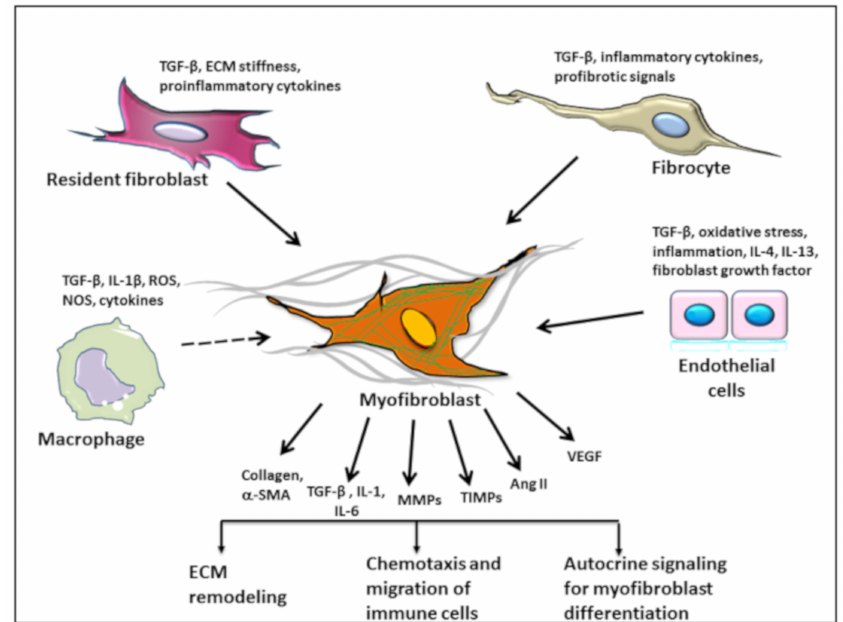
Figure 1. Various progenitor cells lead to the origin of myofibroblasts in atherosclerosis and aortic valve sclerosis. Resident fibroblasts in the tissue and fibrocytes undergo di ff erentiation under the influence of TGF- β , ECM sti ff ness, proinflammatory cytokines, and profibrotic signals. Endothelial cells undergo an endothelial to mesenchymal transition (EndMT) under the influence of oxidative stress, inflammation, TGF- β , IL-4, IL-13, and fibroblast growth factor. TGF- β , IL-1 β , ROS, NOS, and cytokines facilitate the activation of macrophages, which are a major source of profibrotic cytokines, leading to an indirect myofibroblast di ff erentiation through hematopoietic cells. The relative contribution of various cell types to the myofibroblast population is variable and depends on the degree of fibrosis. TGF- β : transforming growth factor- β ; ECM: extracellular matrix; IL-4: interleukin-4; IL-13: